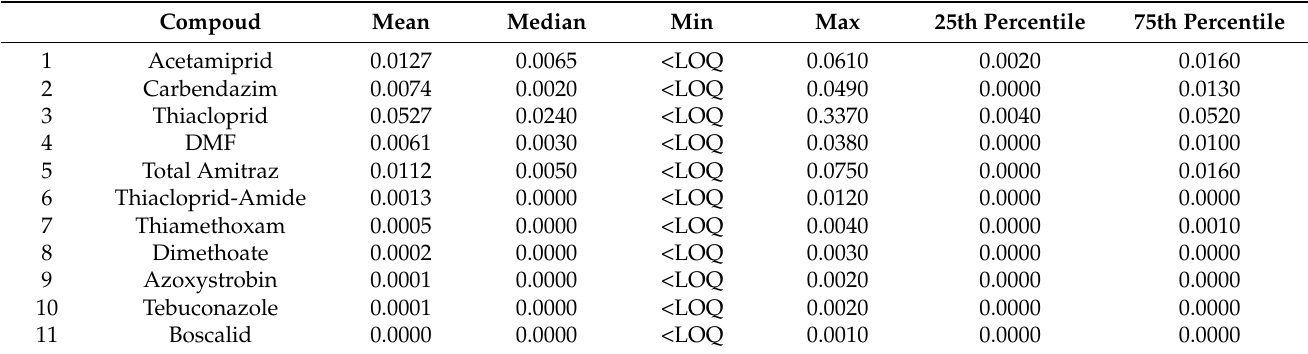
Table 3. Descriptive statistics of pesticide residues (mg/kg) detected in honey.